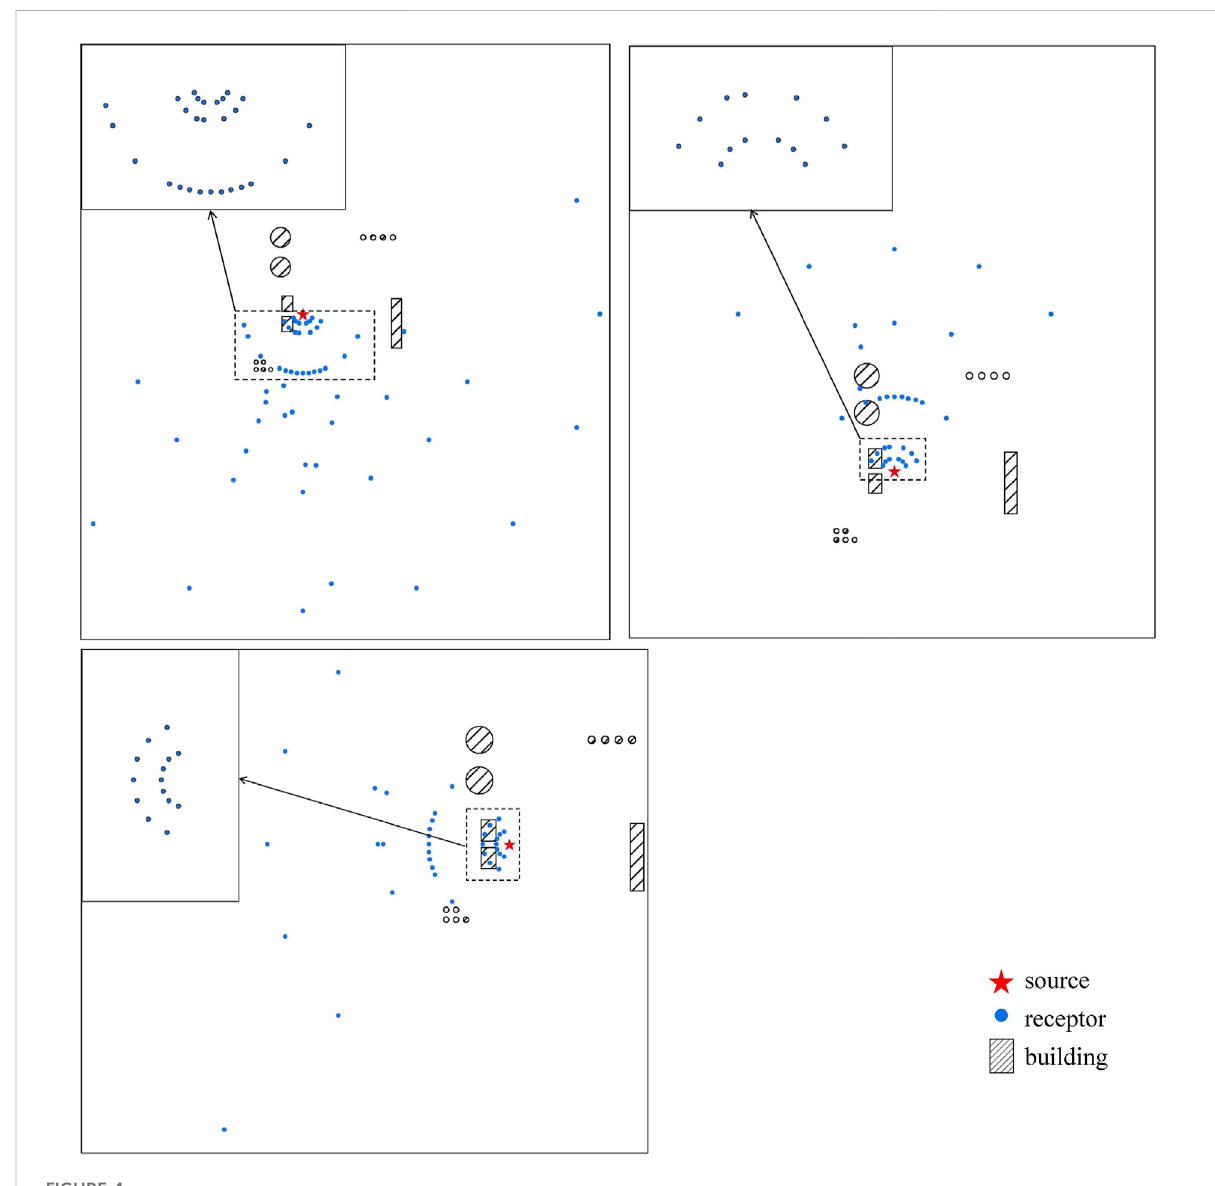
FIGURE 4 Map of measurement points and buildings in the